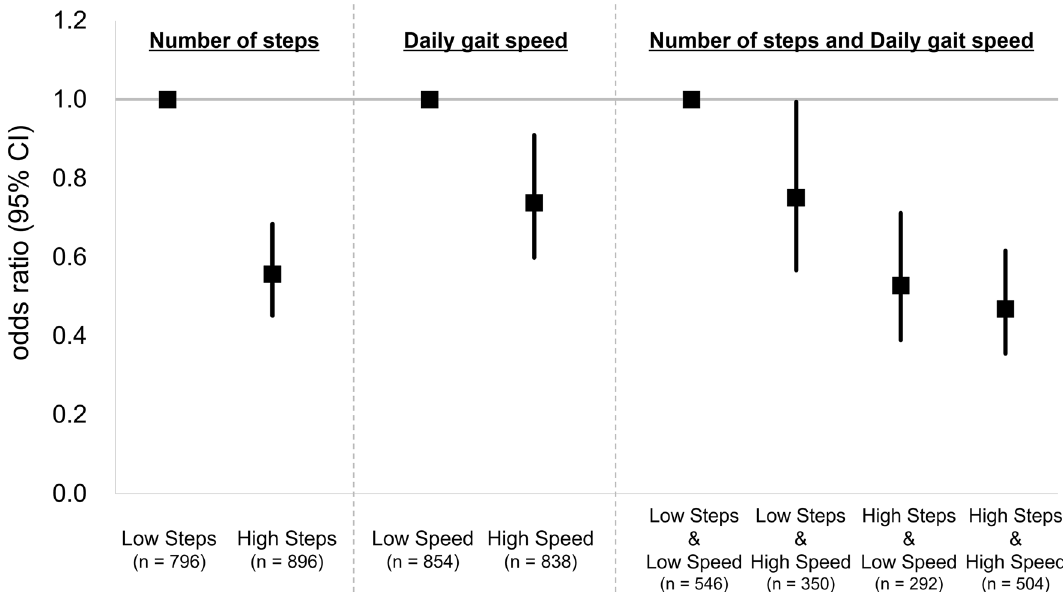
Figure 1. Odds ratios (95% CI) of the three models (number of steps, daily gait speed, and combined two parameters) for prefrailty based on the cut-off values for number of steps and daily gait speed. + Adjusted variables were age, sex, and body mass index (BMI). CI = confidence